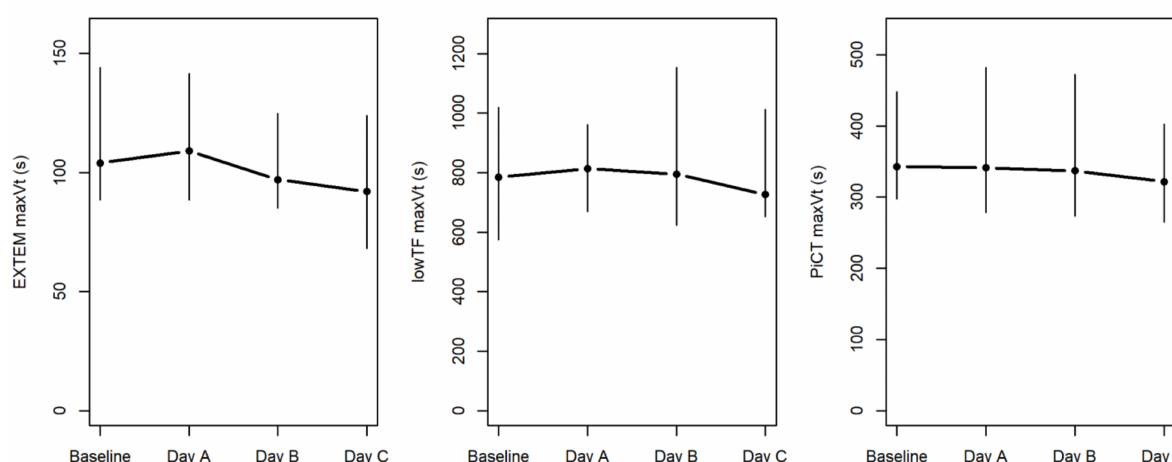
Figure 2. ROTEM data at baseline and during each day in the ICU. Parameters of clotting time (CT), maximum velocity (maxV), and time to maximum velocity (maxVt) were measured by standard EXTEM (i.e., extrinsically activated ROTEM) and by two modified assays of low-TF (low-tissue-factor) ROTEM and PiCT (prothrombinase-induced clotting) NATEM (i.e., non-activated ROTEM) known to correlate greatly with anti-Xa levels [14]. Median values for the four examinations are connected by horizontal lines, with vertical lines extending from the 1st to 3rd quartiles. The area highlighted in gray indicates the only available reference range (for CT by